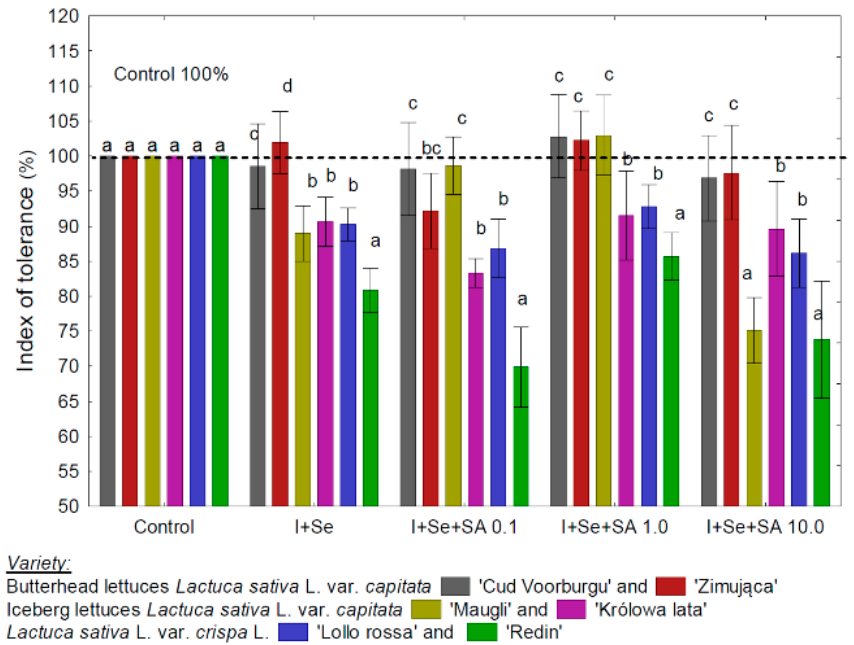
Figure 1. Index of tolerance. Means for cultivars followed by the same letters separately for each treatment (type of nutrient solution) are not significantly different at p < 0.05. Bars indicate standard errors ( n = 8).